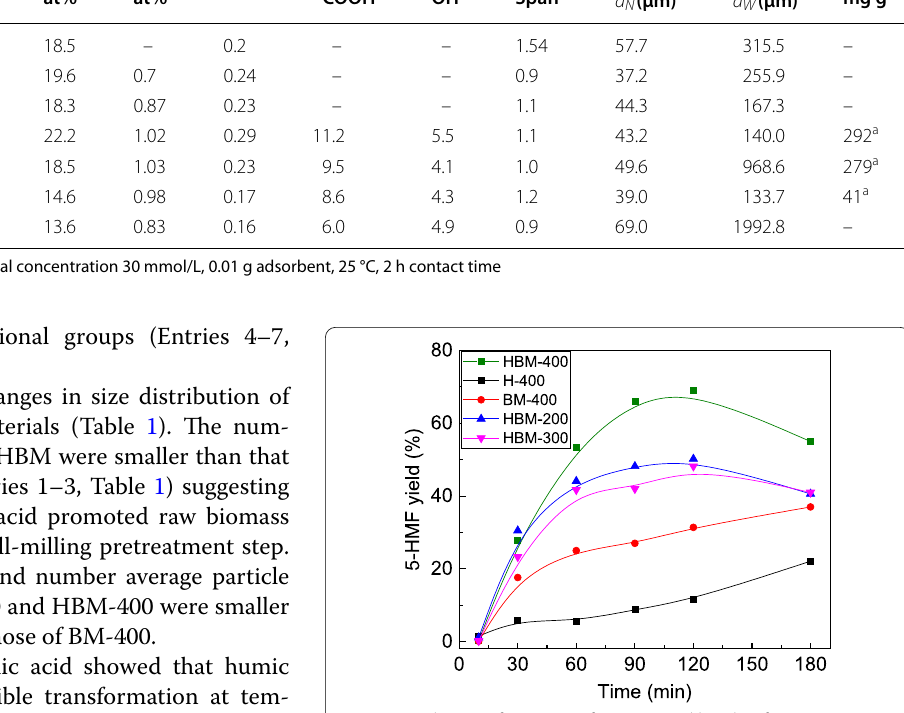
Fig. 5 Catalytic performance of as-prepared biochar for conversion of fructose into 5-hydroxymethylfurfual (5-HMF) at 120 °C in ionic liquid. (reaction conditions: 0.05 g of fructose, 0.05 g of catalyst, 2 g of